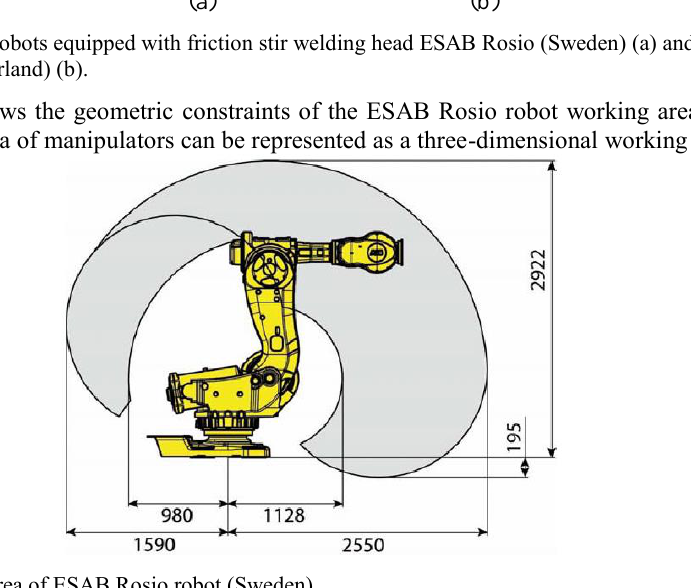
Fig. 6 . Working area of ESAB Rosio robot